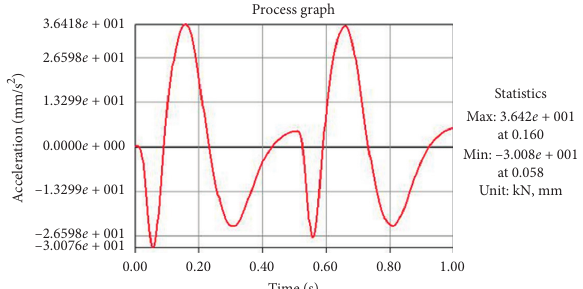
Figure 21: Acceleration at the top of the foundation pit cover near the wharf.